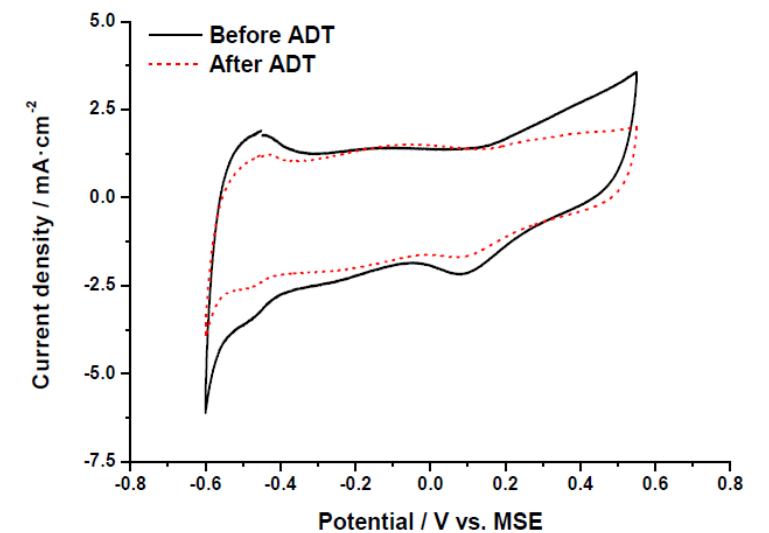
SO , 25 °C) before 2 4